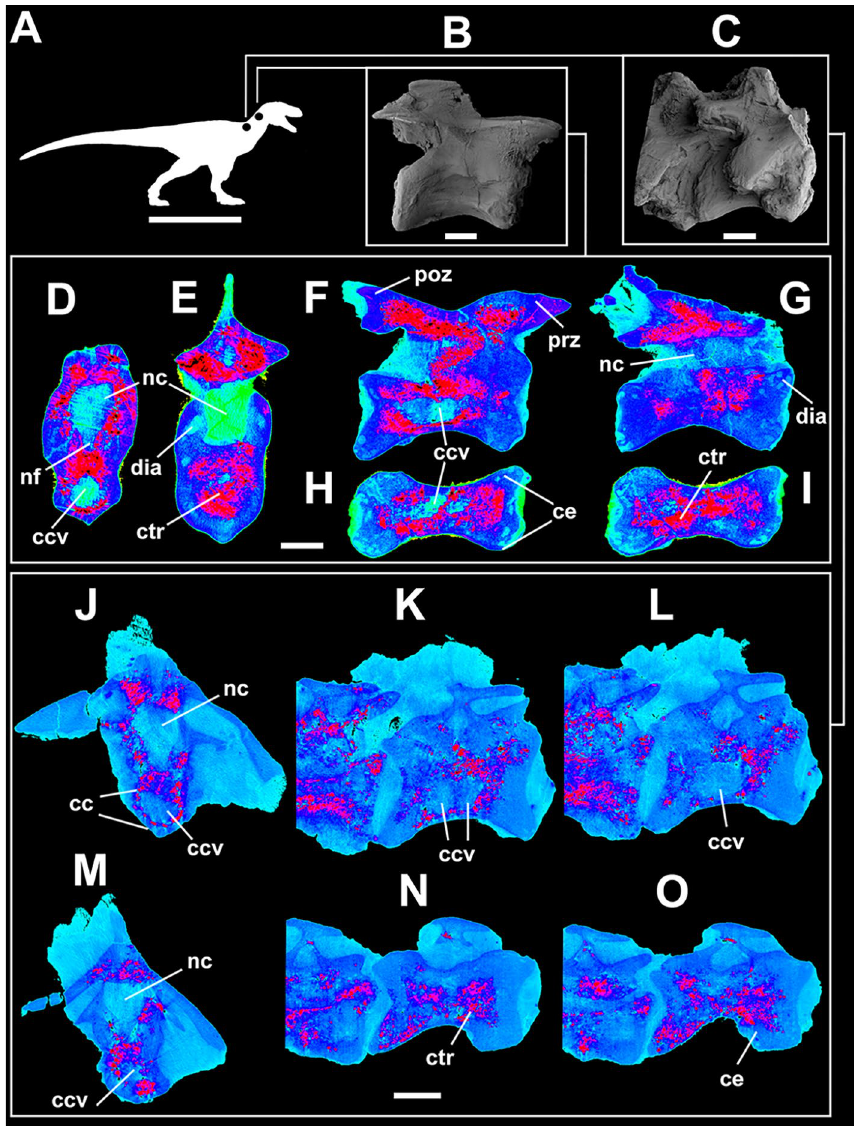
Figure 5. Micro-computed tomography of the vertebrae of the herrerasaurid Gnathovorax (CAPPA/UFSM- 0009). ( A ) silhouette shows the position of the axial elements. Artist: Felipe Elias. ( B ) 3D reconstruction of the anterior cervical vertebra and the correspondent high-contrast density slices in ( D-I ). Diagenetic artifacts greatly compromised the internal structures. ( C ) 3D reconstruction of the articulated posterior cervical vertebrae and the correspondent high-contrast density slices in ( J–O ). Minerals infilled between trabecular vacancies generate reddish anomalies. All images indicate irregular, chaotic, apneumatic architecture. Note the apneumatic large chambers in the centrum (ccv) and the smaller circumferential chambers at the bottom (cc). All slices were taken from the approximate midshaft. Anterior views in ( D , H , I ). Right lateral view in ( E , L , M ). Ventral view in ( F , G , J , K ). cc circumferential chambers, ccv chamber in the centrum, ce centrum, ctr chaotic trabeculae, d diapophysis, dia diagenetic artifact, nc neural canal, nf nutritional foramen, poz postzygapophysis, prz prezygapophysis. Scale bar in ( A ) = 1000 mm; in ( B – O ) = 10 mm. Computed tomography data processed with 3D Slicer version 4.10. Figures were generated with Adobe Photoshop CC version 22.5.1